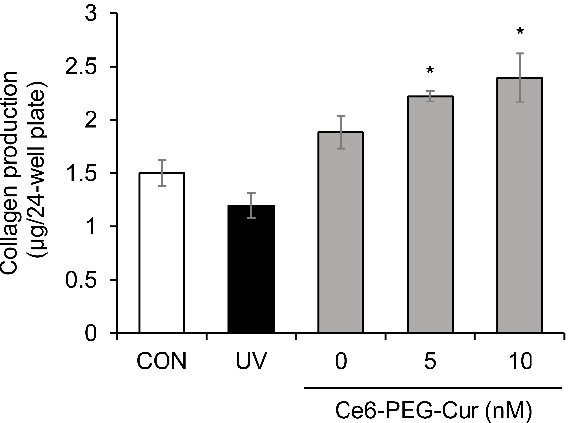
Figure 5. The effect of Ce6-PEG-curcumin-mediated PDT on the phosphorylation p38 MAPK and c-Jun expression in UVB-irradiated HS68 cells. Results are expressed as mean ± SD. * p < 0.05 vs. UVB-irradiated control.